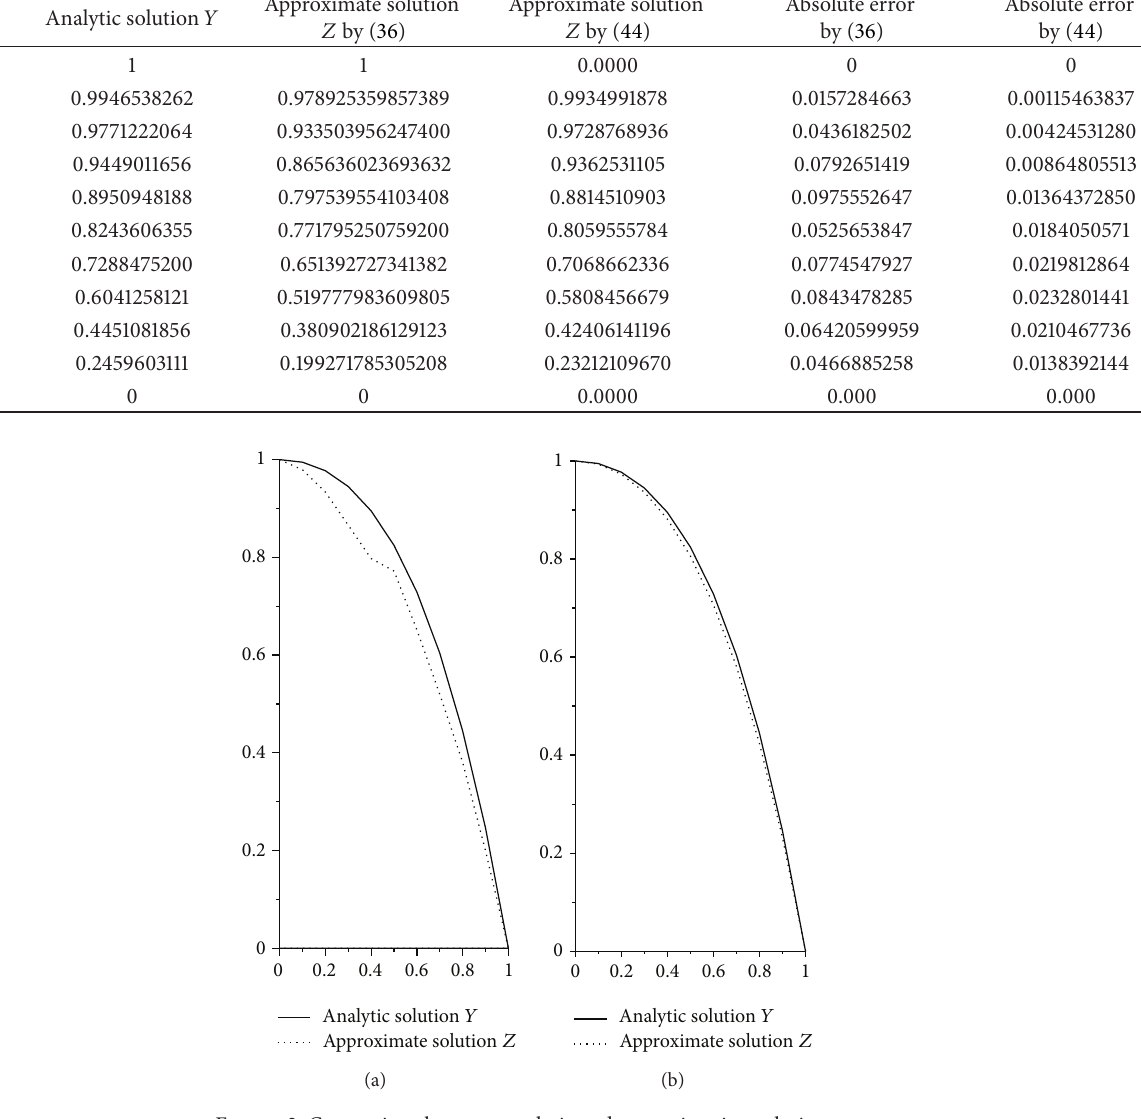
Figure 2: Comparison between analytic and approximating